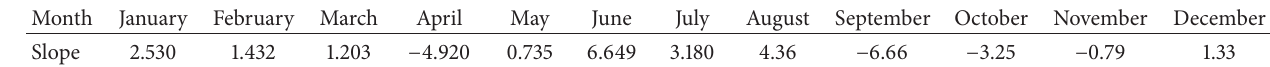
Figure 4: Spatial pattern of mean annual precipitation (a) and its slope and trend (b); rainy days (c) and its slope and trend (d). Table 4: Theil-Sen’s slope for monthly